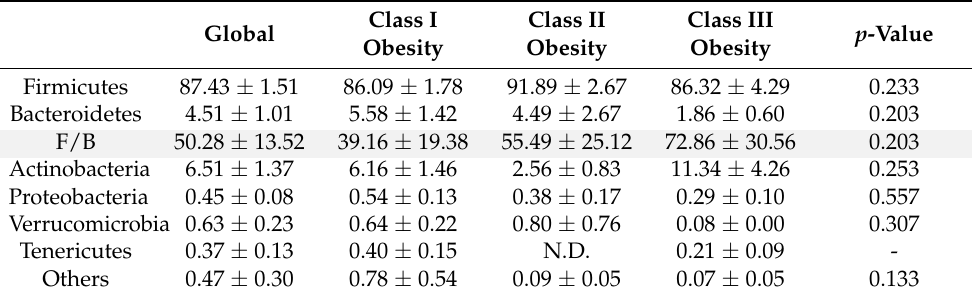
Table 4. Relative abundance of significant gut microbiota phyla and Firmicutes/Bacteroidetes ratio in participants before orange juice intake (basal